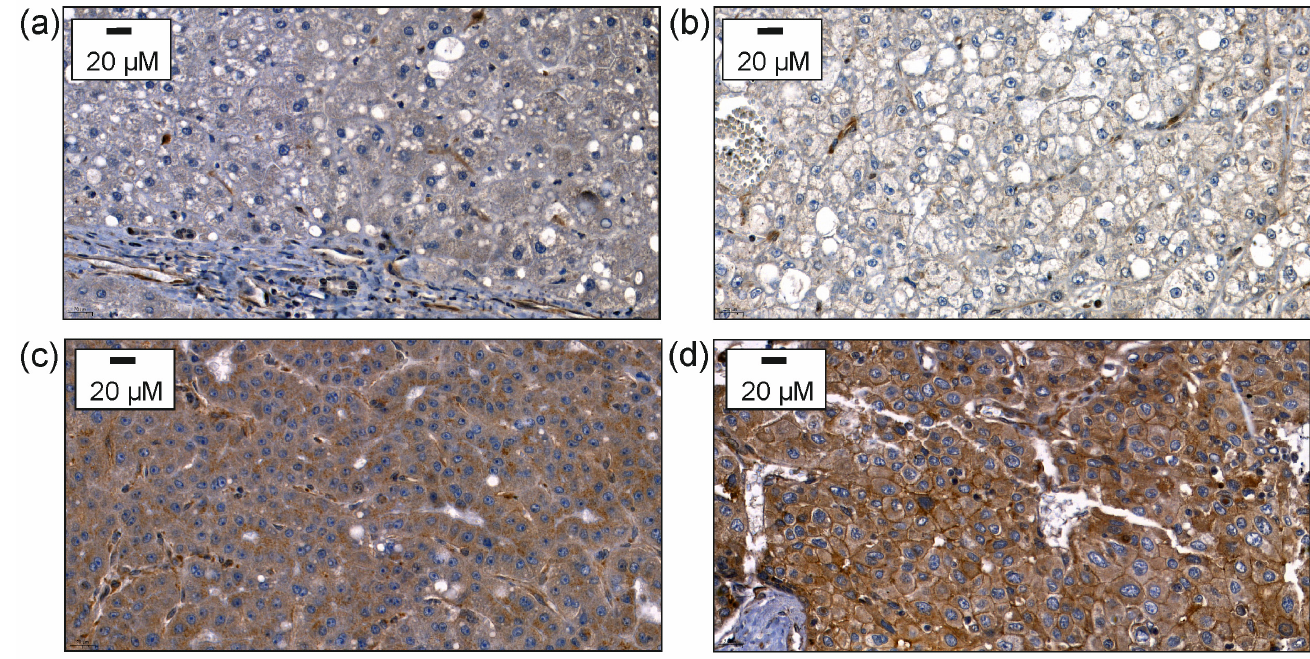
Figure 1. Immunohistochemical expression of chemerin. After staining with the antibody, the slides were counterstained with hematoxylin. ( a ) Immunohistochemical expression of chemerin in non-neoplastic liver tissue of a patient suffering from HCC. ( b ) Immunohistochemical expression of chemerin in HCC tissue with staining of hepatocytes scored as 1 for weak cytoplasmic stain- ing. ( c ) Immunohistochemical expression of chemerin in HCC tissue with staining of hepatocytes scored as 2 for moderate staining; ( d ) Immunohistochemical expression of chemerin in HCC tissue with staining of hepatocytes scored as 3 for strong heterogeneous or patchy cytoplasmic and/or membranous